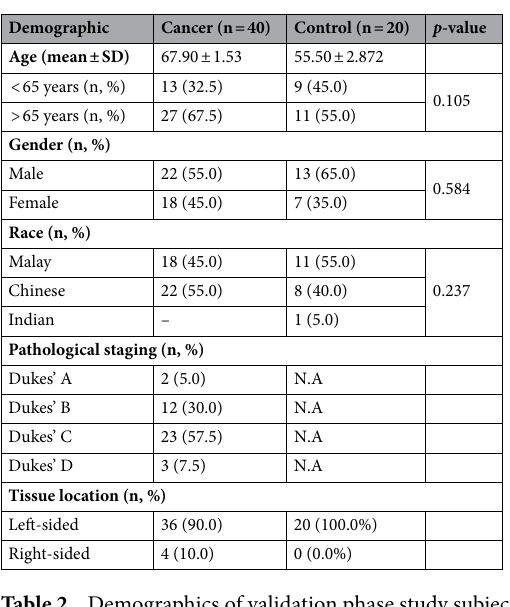
Table 2. Demographics of validation phase study subjects.